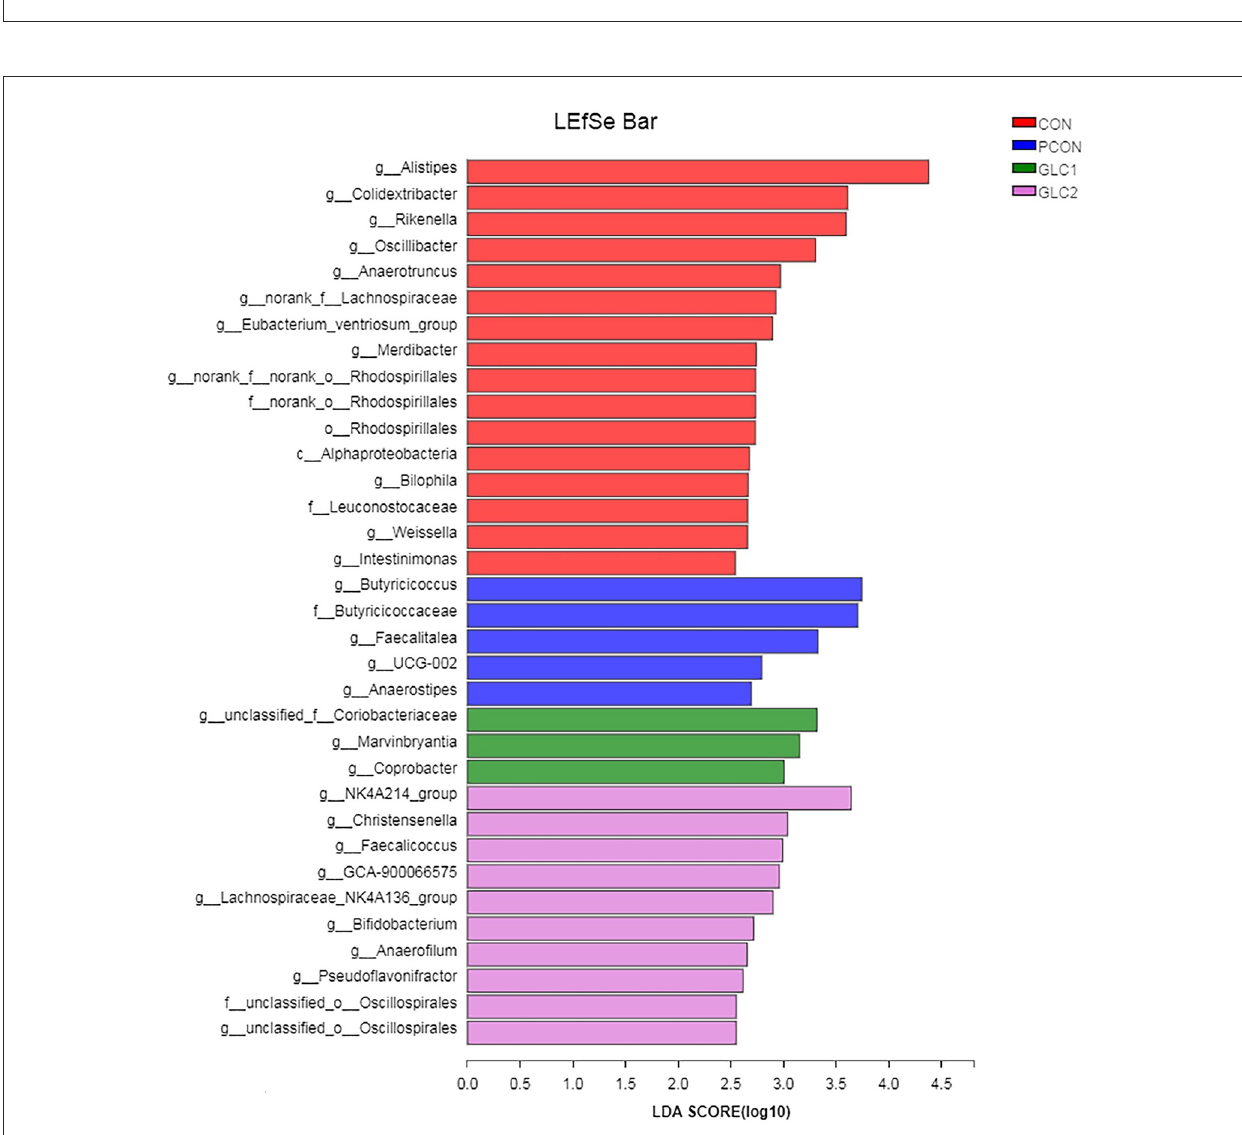
FIGURE6 Effect of Ganoderma lingzhi culture (GLC) supplementation on LEfSe analysis of the caecal microbiota ( n = 6; CON, control diet; PCON, positive control diet; GLC 1: 1.5% GCL diet; GLC 2: 3% GCL diet).